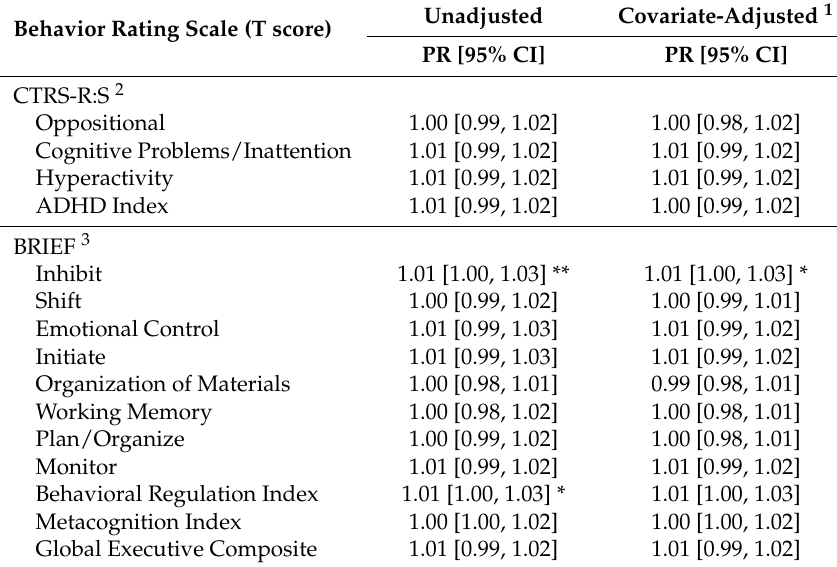
Table 2. Association (prevalence ratio) between blood lead concentrations and behavior ratings by teachers among 5–8-year-old children from Montevideo, Uruguay ( n = 206).